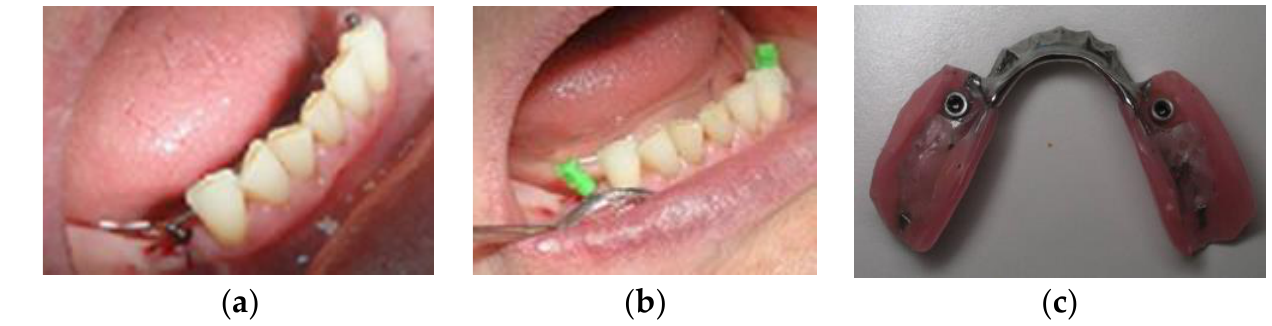
Figure 2. ( a ) Mini-implants after insertion; ( b ) Transfer caps attached to mini-implants before custom impression; ( c ) Denture at delivery with metal-housing and “o” -rings.